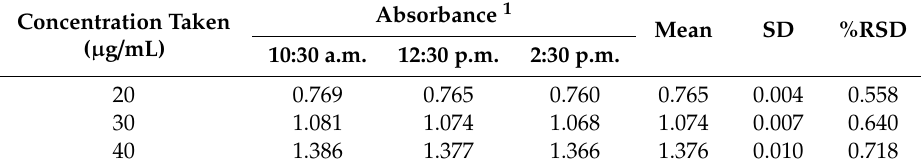
Table 8. Results of intraday precision using UV-vis spectrophotometer. Concentration Taken